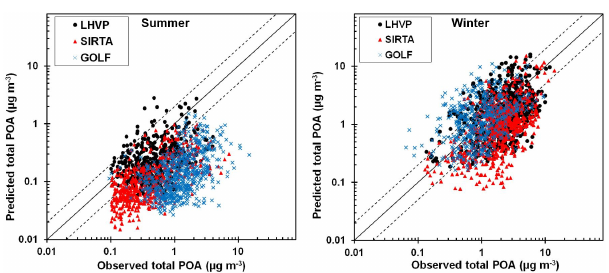
Figure 3. Comparison of predicted vs. observed PM 1 total POA (µgm − 3 ) from the three measurement stations during the MEGAPOLI summer and winter campaigns. Each point is an hourly average value. Also shown are the 1:1, 2:1 and 1:2 lines. Observed data represent AMS factor-analysis